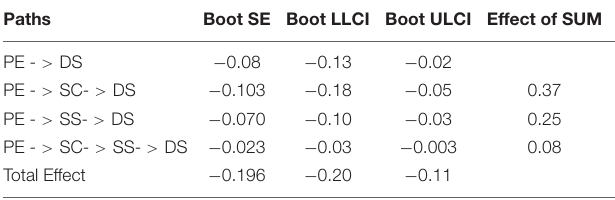
TABLE 2 | Bootstrap mediating effects of social support and self-concept.